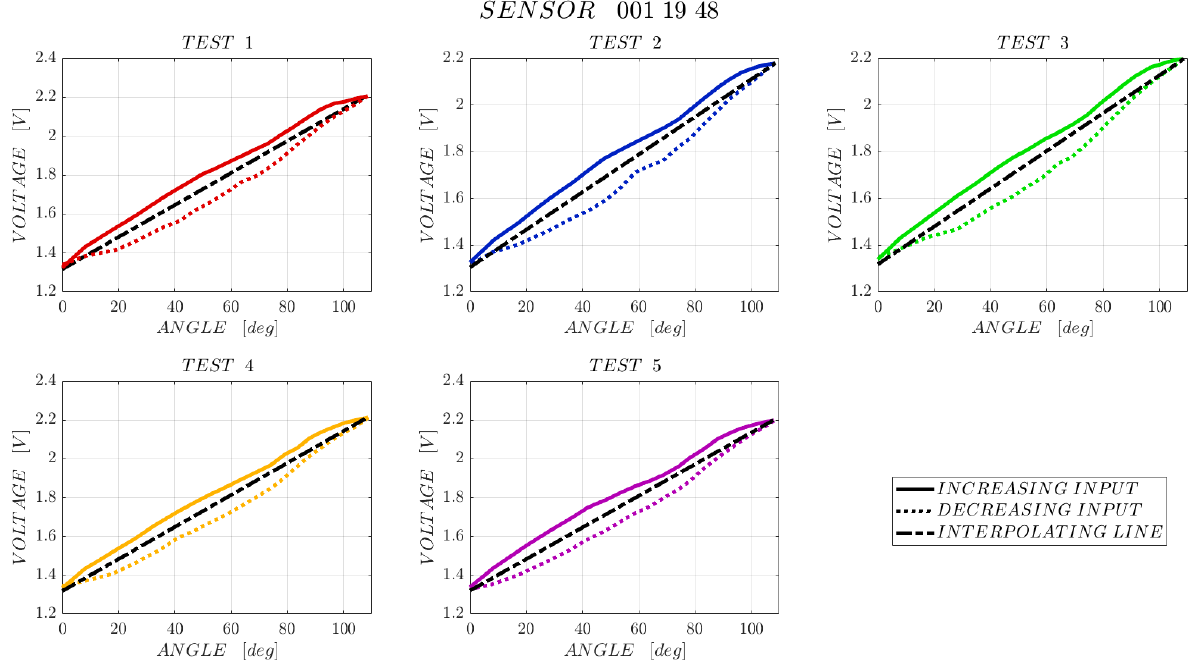
Figure 22. Reference lines for the sensor 001 19 48.